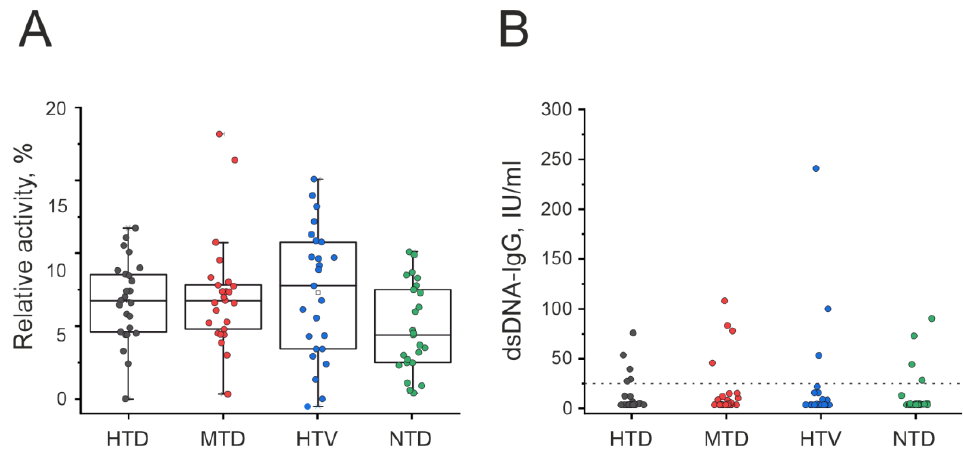
Figure 7. Summarized data of the DNAse activity in HTD, MTD, HTV, and NTD: 100% was taken as complete hydrolysis of plasmid in 24 h by antibodies in a concentration of 0.01 mg/mL ( A ). Contents of anti-dsDNA-IgG shown no statistically significant differences between groups ( B ).